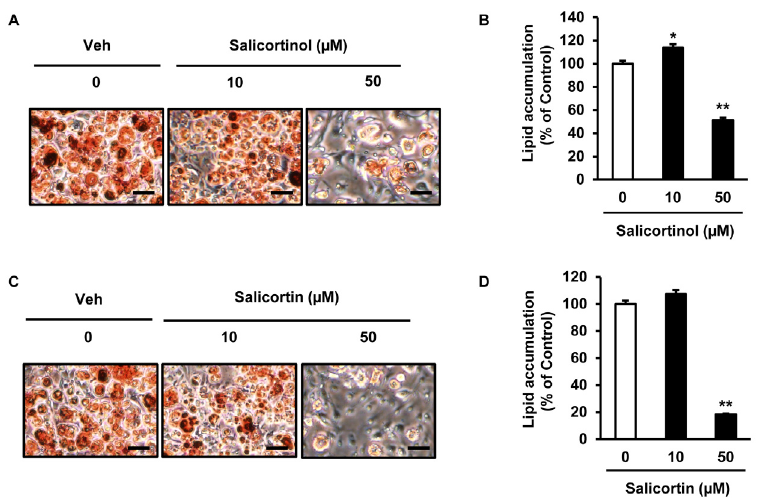
Figure 3. Inhibitory effect of salicortinol and salicortin on lipid accumulation in 3T3-L1 cells: ( A ) microscopy images of cells treated with different concentrations of salicortinol (as indicated) during adipocyte differentiation, followed by oil red O staining; ( B ) Quantification of intracellular lipid accumulation in salicortinol-treated 3T3-L1 cells; ( C ) microscopy images of cells treated with different concentrations of salicortin (as indicated) during adipocyte differentiation, followed by oil red O staining; and ( D ) Quantification of intracellular lipid accumulation quantification in salicortin-treated 3T3-L1 cells. B and D, n = 3 per group. The values represent the mean ± SEM. Scale bar = 100 µm. * p < 0.05, ** p < 0.01. Veh, vehicle (negative control).